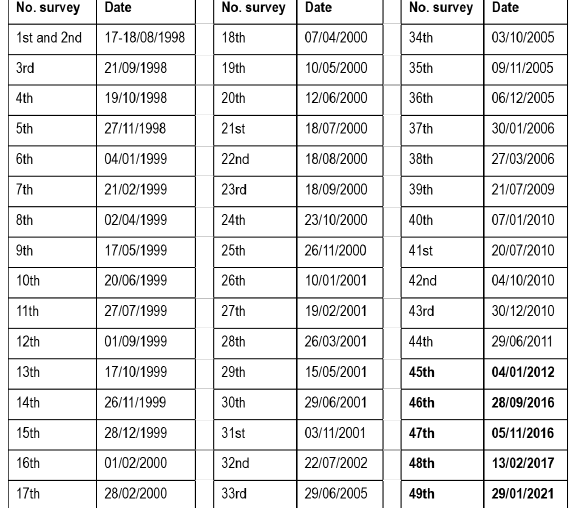
Figure 2. List of topographic levelling network surveying